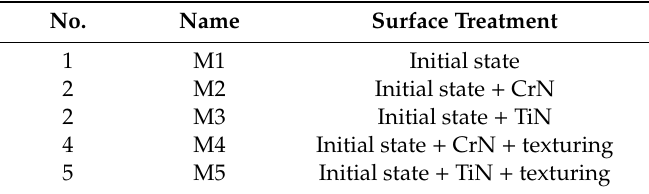
Table 4. Identification of the tested